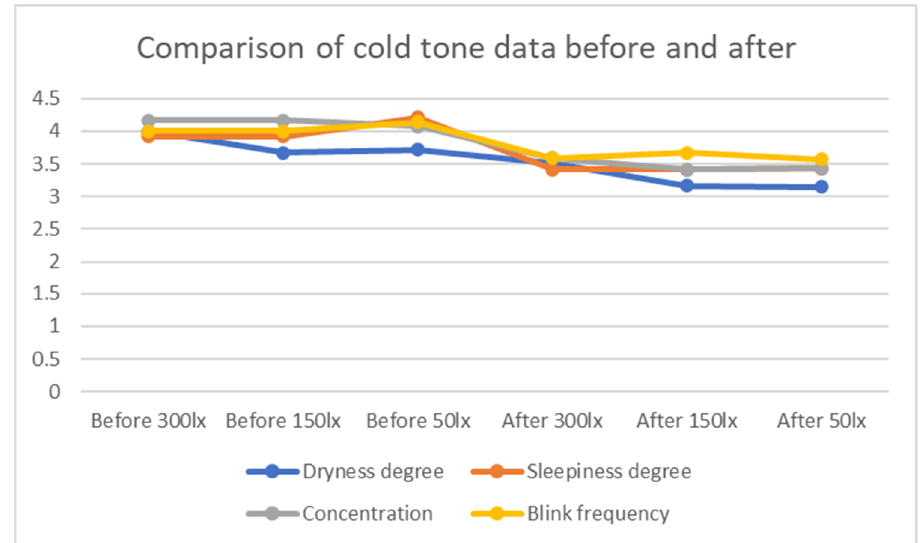
Figure 3. Line chart of visual fatigue rating before and after the experiment under three illumination levels in the cold tone paintings.